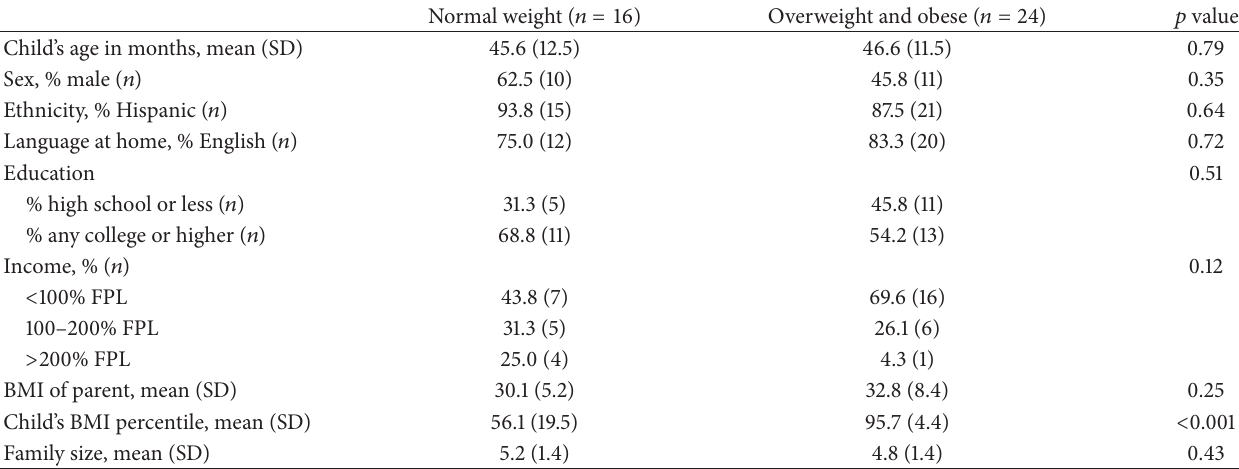
Table 1: Demographic characteristics of the subjects by weight category.